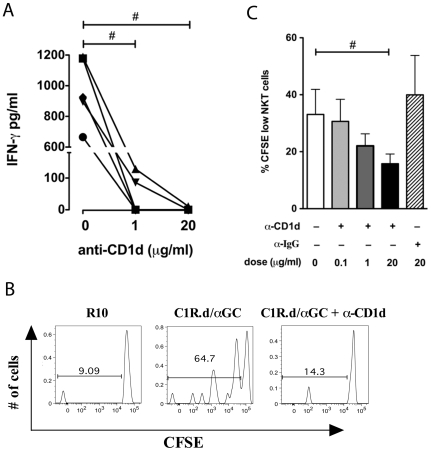
Sooty mangabey NKT lymphocytes respond to NKT ligands in a CD1d-restricted manner.A) IFN-γ ELISA on culture supernatants of NKT clones stimulated with C1R.d/α-GalCer (50 ng/ml) for 16 hours in the presence of anti-CD1d antibody (clone 42.1) at 0, 1, and 20 µg/ml. Data shows IFN- γ secretion from five clones. B) Representative histogram plots gated on NKT lymphocytes showing proliferation assessed by CFSE staining after 5 days of CD1d/α-GalCer stimulation in the presence or absence of anti-human CD1d mAb (clone 42.1). C) Dose-dependent reduction in proliferation of NKT cells with anti-CD1d. Mean and SEM of five NKT clones shown.